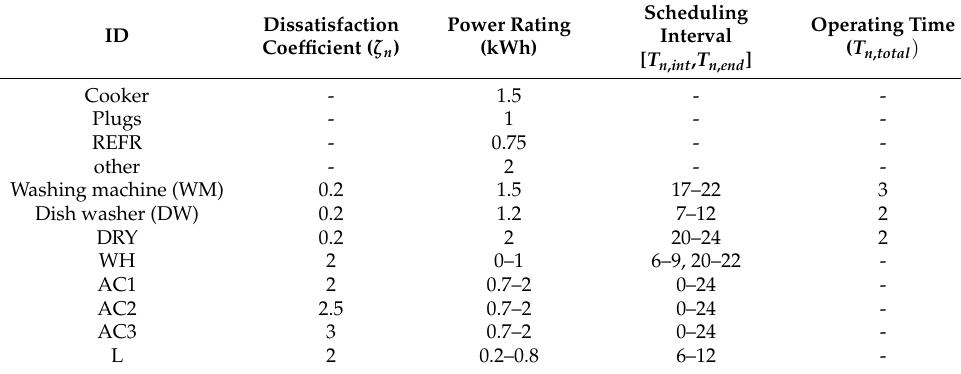
Table 1. Parameters of household appliances.